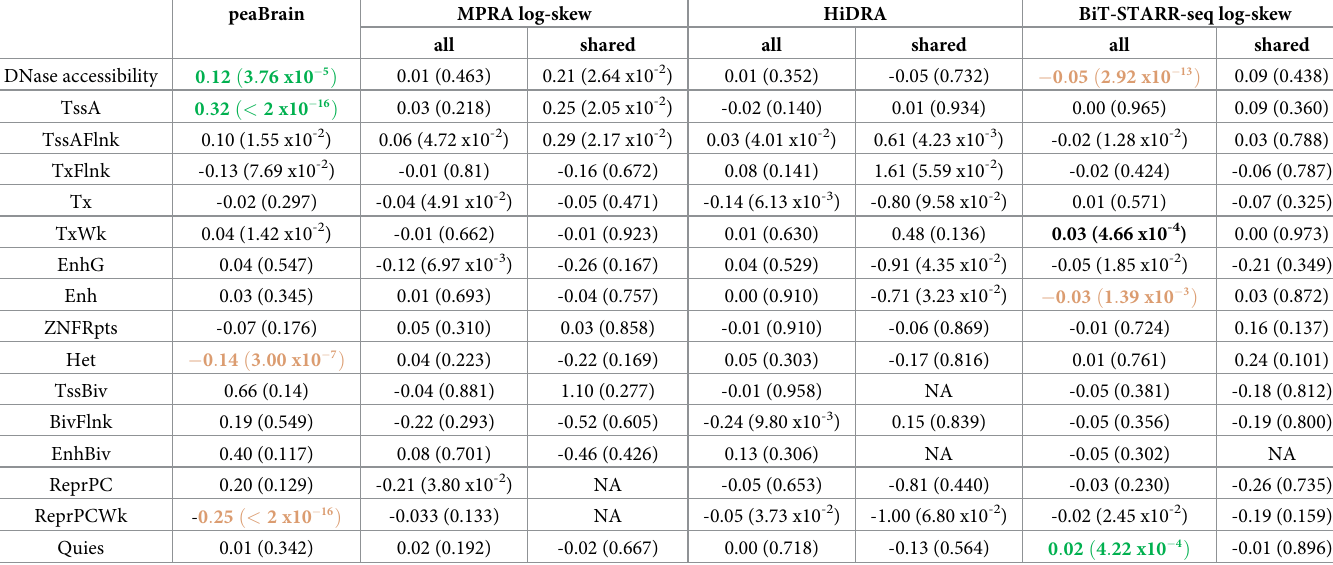
Table 2. In the 113 “captured” genes, eQTL variants with higher peaBrain estimates (i.e. more likely to be functional and with larger predicted transcriptomic impact) tended to fall in DNase accessible sites and transcriptionally active regions, and were similarly depleted from quiescent and repressed sequences (Task G). peaBrain MPRA log-skew